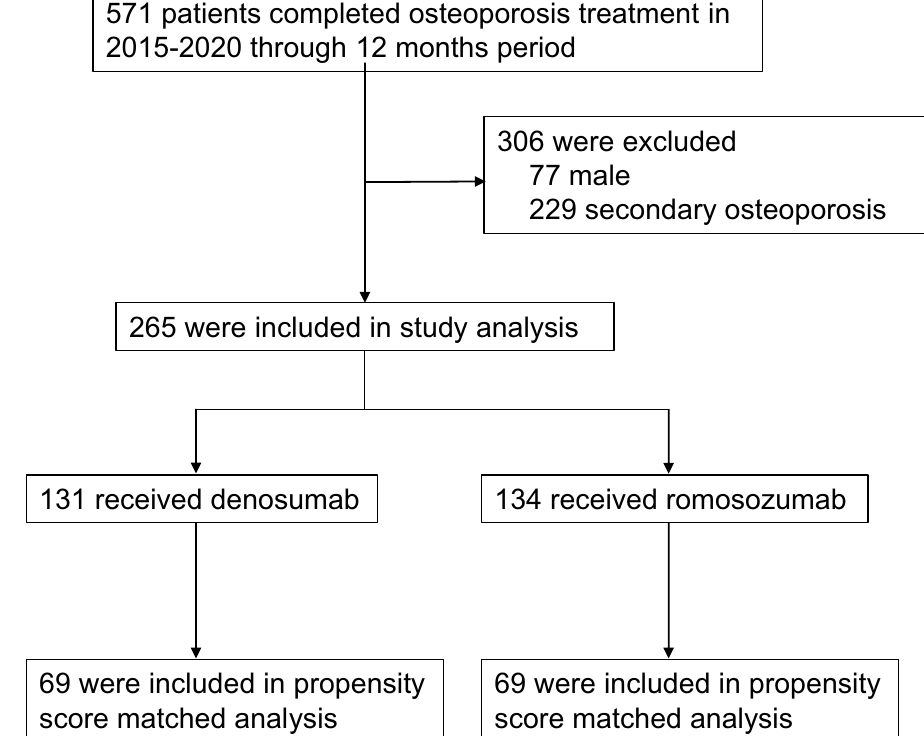
Figure 1. Subject flow diagram throughout the 12-month denosumab and romosozumab treatment period. Propensity score matching was employed to extract subjects.